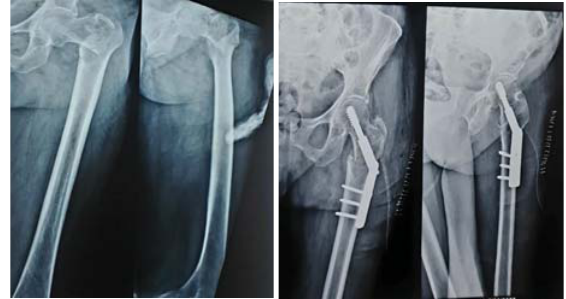
Figure 2. DHS radiograph (preoperative and